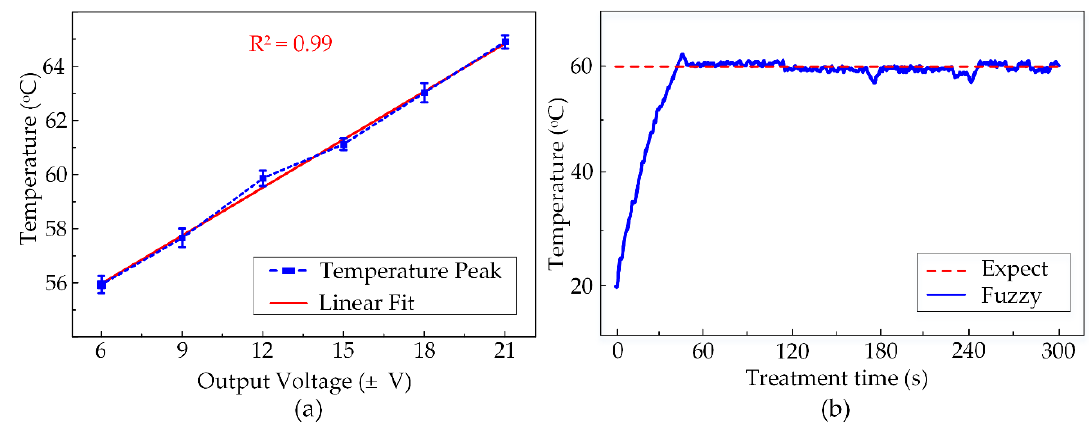
Figure 8. ( a ) The temperature peaks reached by various output voltages (N = 5) ( b ) Temperature observation during 300 s of Fuzzy-control HIFU treatment.